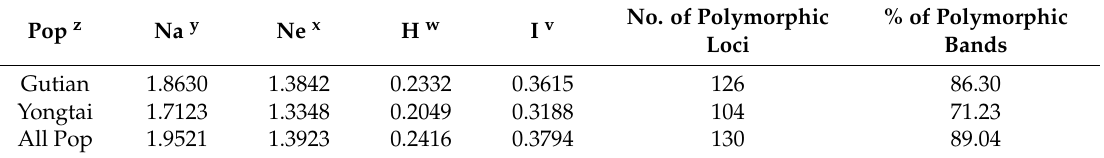
Table 3. Genetic variability among 33 plum varieties analyzed using 14 ISSR